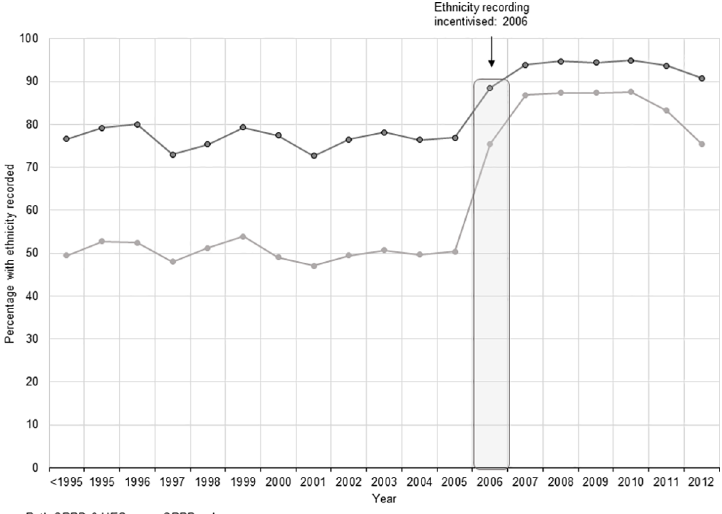
Fig 1. Patients with ethnicity records in Clinical PracticeResearchDatalink and Hospital Episode Statistics over time. Abbreviations: CPRD ClinicalPractice ResearchDatalinkHES HospitalEpisode